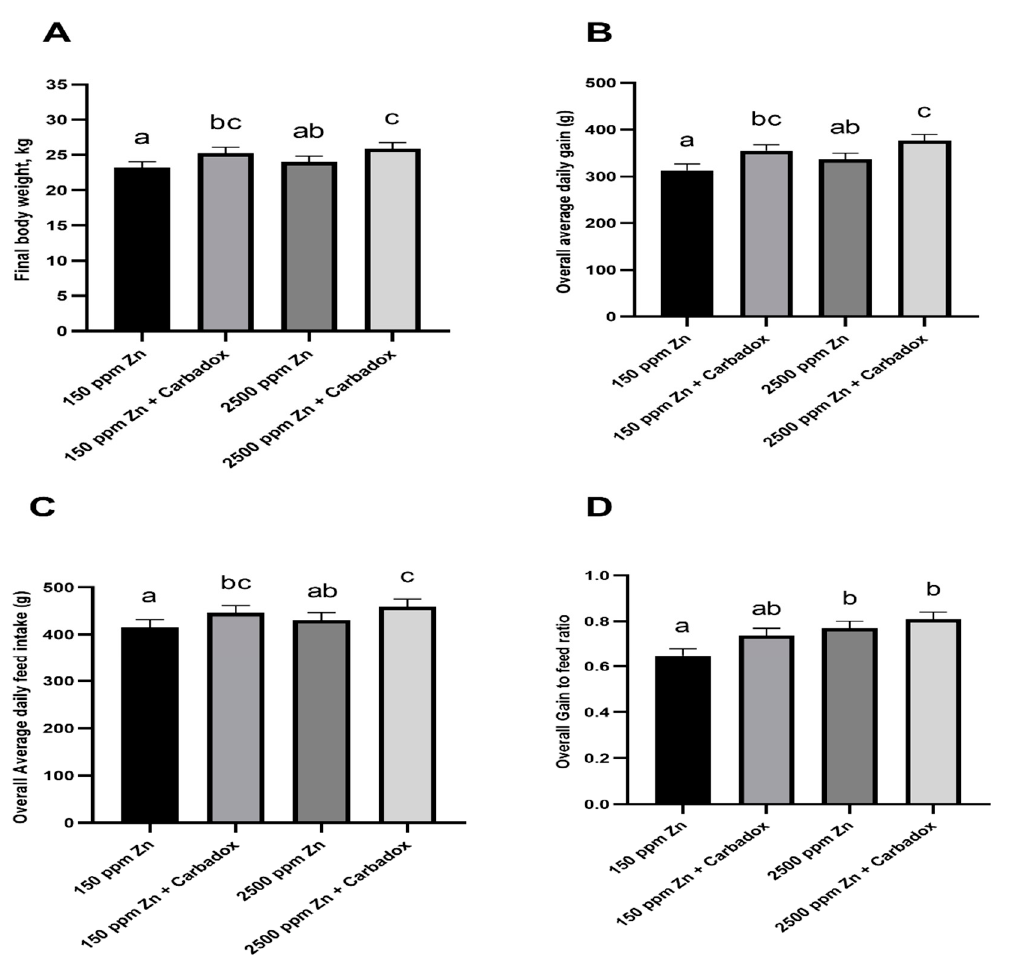
Figure 1. Final body weight ( A ), overall average daily gain ( B ), feed intake ( C ), and gain to feed ratio ( D ) of weaned pigs fed diets containing a pharmacological dose of Zn (2500 ppm) and carbadox. Different letters indicate significant differences ( p < 0.05). Bars represent least squares means ± standard error of the mean.